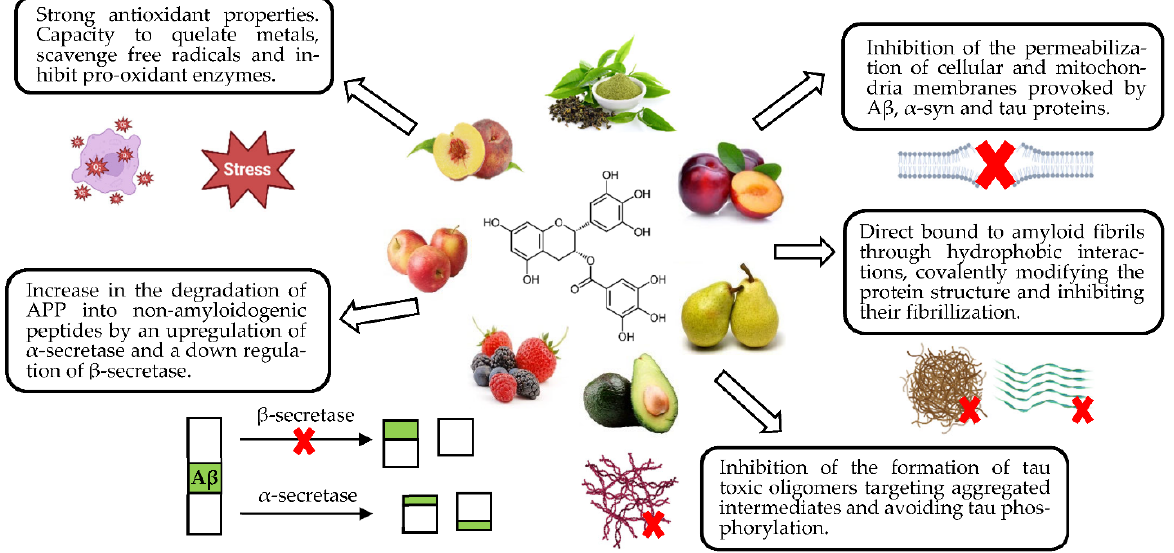
Figure 3. Neuroprotective molecular targets of EGCG in amyloidogenic pathologies.